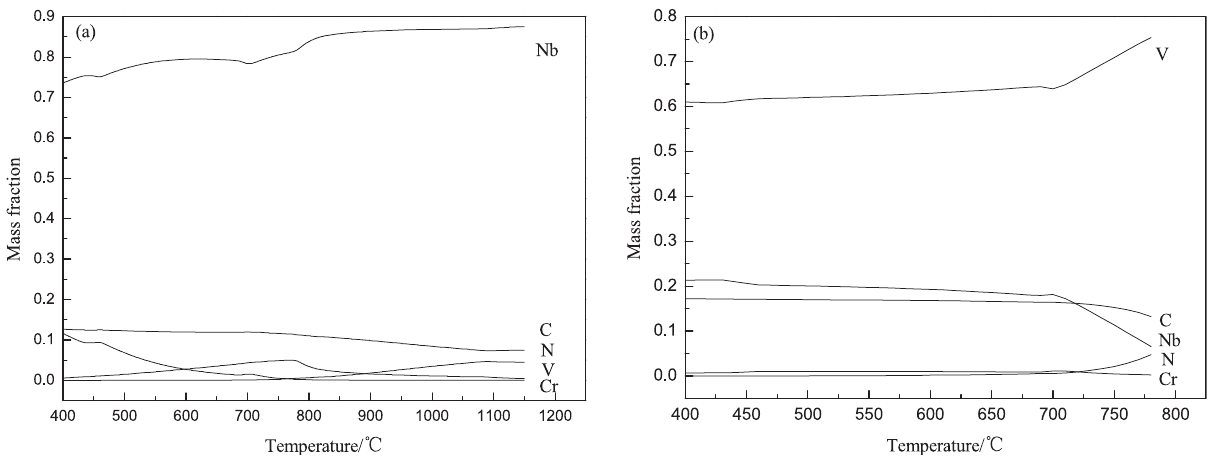
Fig. 2: The temperature dependence of compositions for MX phases in Q345E applicable to cryogenic flange: (a) MX#1 phase; (b) MX#2